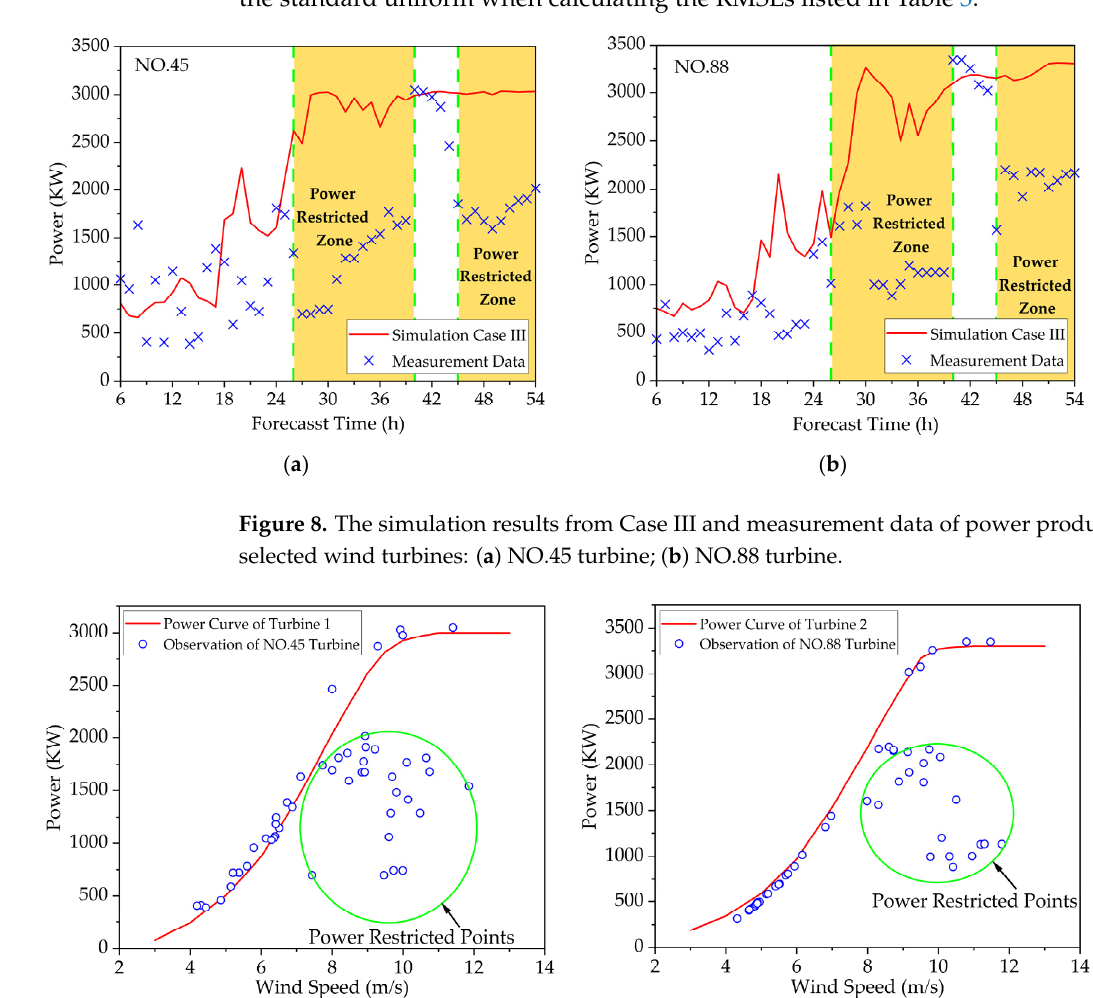
Figure 8. The simulation results from Case III and measurement data of power production for the